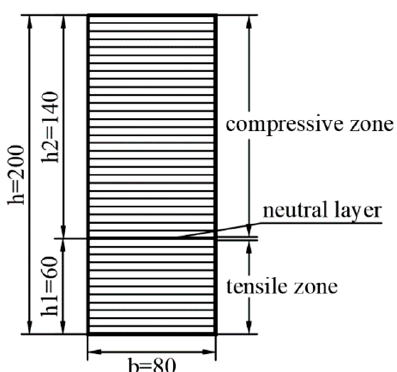
Figure 5. Sketch of layering on cross section of a bimodular FGPM cantilever beam (unit: mm).